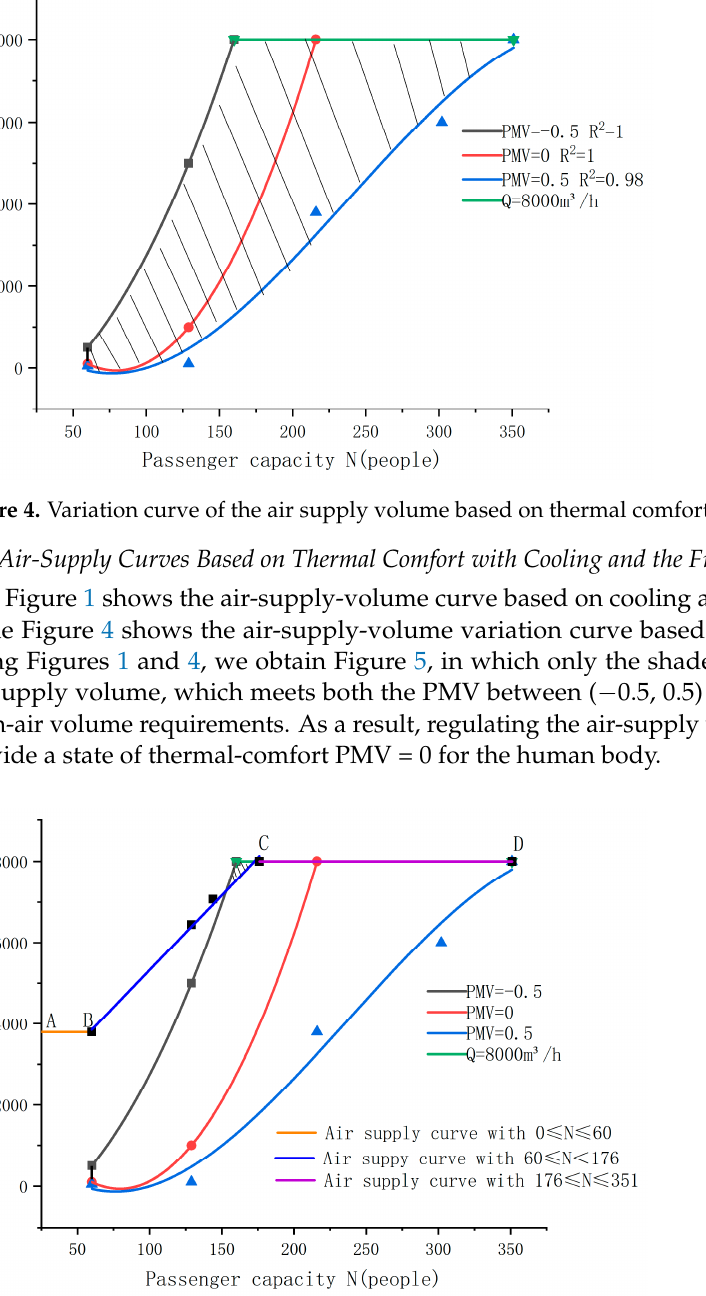
Table 5. Air-supply volume under different passenger-capacity conditions Q (m 3 /h).